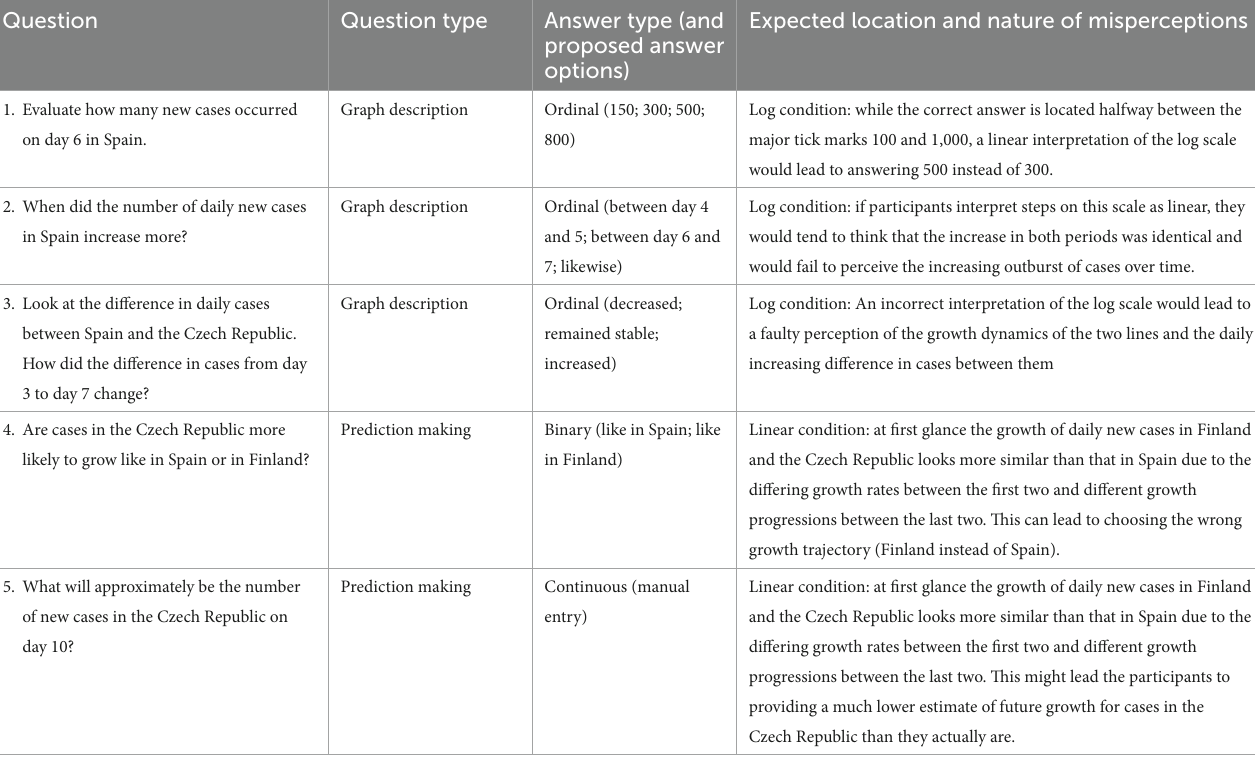
TABLE 1 Questions asked during the experiment and their characteristics.